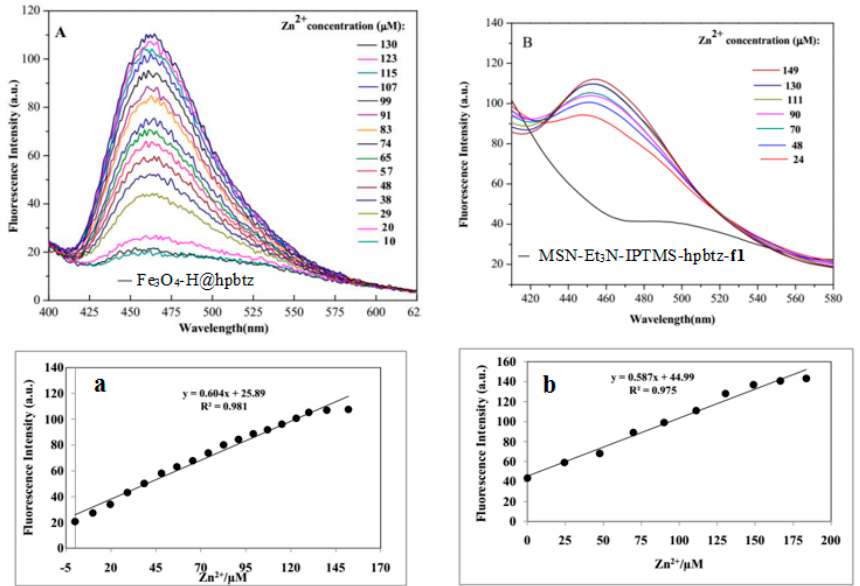
Figure 10. Fluorescence intensity changes observed in ( A ) Fe 3 O 4 -H@hpbtz (2 mg mL − 1 ) and ( B ) MSN-Et 3 N-IPTMS-hpbtz- f1 (2 mg mL − 1 ) upon the addition of Zn 2+ (0–7.8 equivalent, 0–130 µ M and 300 µ L for A, and 0–15.4 equivalents, 0–130 µ M and 350 µ L for B) at λ ex = 350 nm for Aa and 305 nm for B in the ethanol (a and b: plot of the fluorescence intensity at 460 nm as a function of the Zn 2+